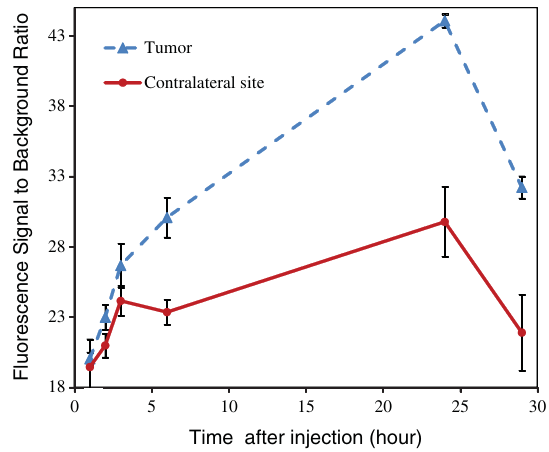
Fig. 6. Monitoring the uptake of AngioSense 750 at the tumor com- pared to the contralateral site (control) in three mice. The higher uptakeatthetumorsiteindicatesitshighervascularization.Thefluo- rescenceintensityatthetumorandcontralateralsiteswasnormalized to the background intensity of the tumor area before injection (after